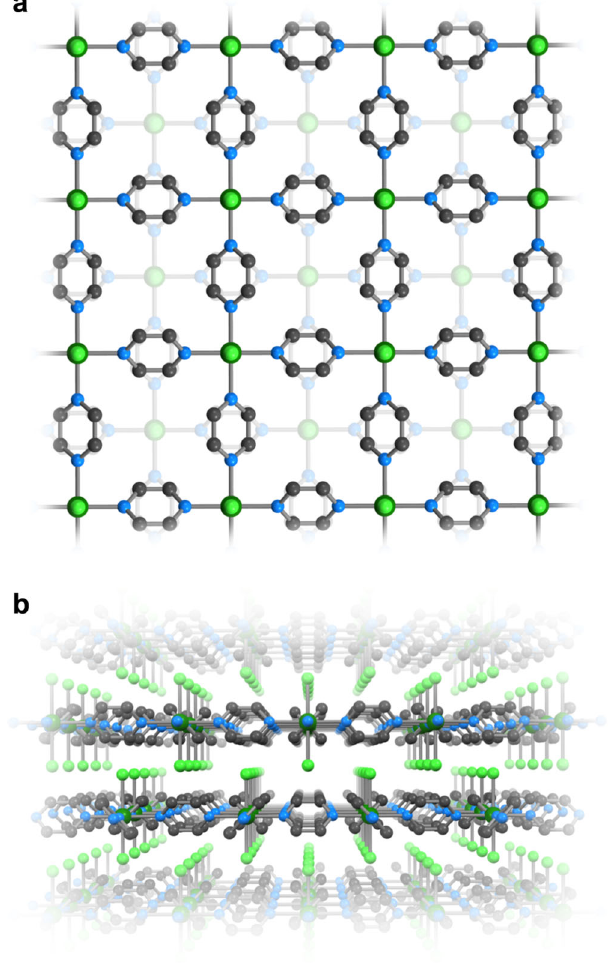
Fig.1|X-raycrystalstructure. Structureof VCl 2 (pyz) 2 asdeterminedfromsingle- crystal X-ray diffraction ( T = 120(1)K) shown perpendicular ( a ) and parallel ( b ) to the 2D layers. Only one orientation of the positionally disordered pyz ligands is shown. Color code: V, dark green; Cl, green; N, blue; C,